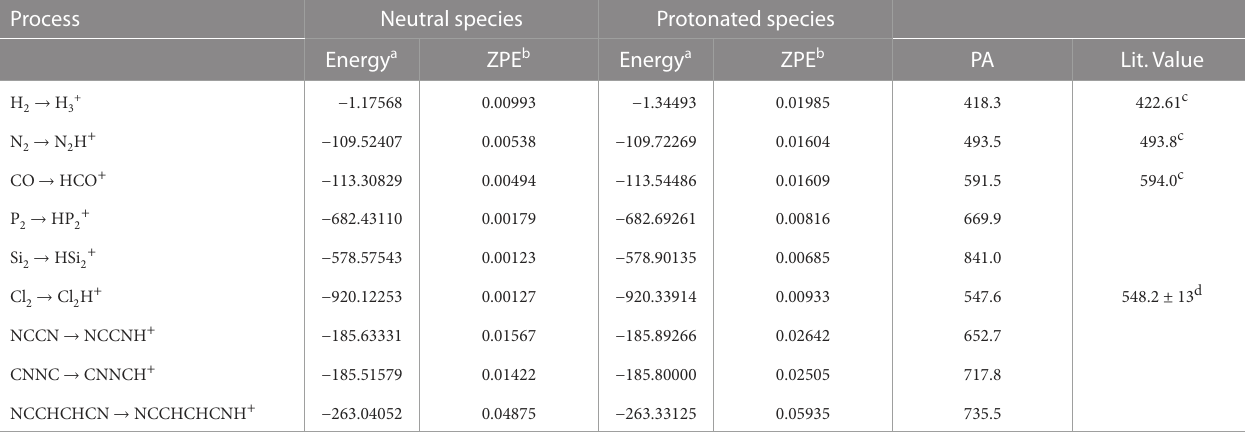
TABLE1 Computedprotonaffinities(kJ mol − 1 )forthemoleculesconsideredinthiswork.ElectronicenergiesandZPEareinHartrees.